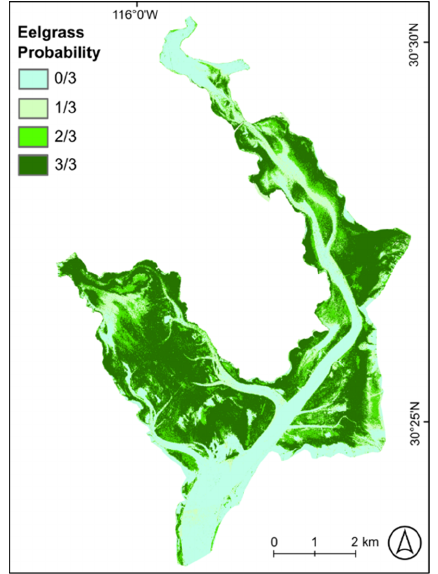
Figure 5. Eelgrass probability map, displaying the fraction of seasonal SVM classifications that clas- sify a given pixel as Eelgrass, based on satellite imagery from winter, spring, and fall.